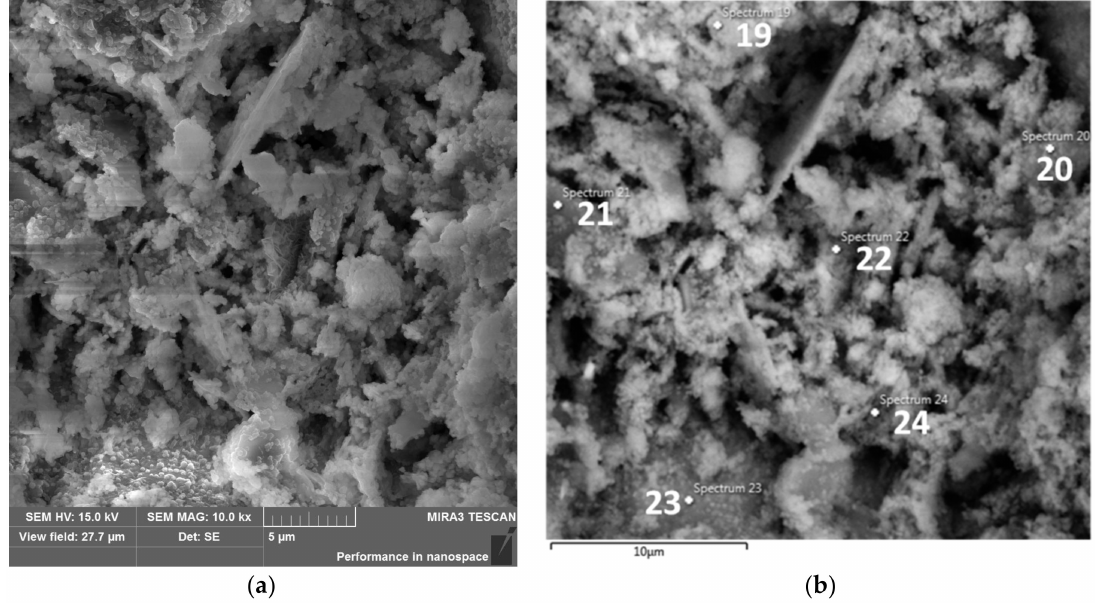
Figure 19. ( a ) SEM-SE image of M.6.0, mag.: 10k × . ( b ) SEM-SE image of M.6.0, mag.: 10k × . Points in which EDS analysis was performed.